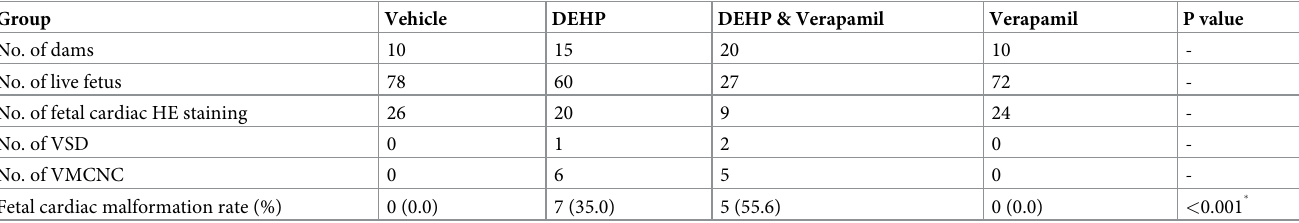
Table 2. Comparison of fetal cardiac malformation rates among different groups.